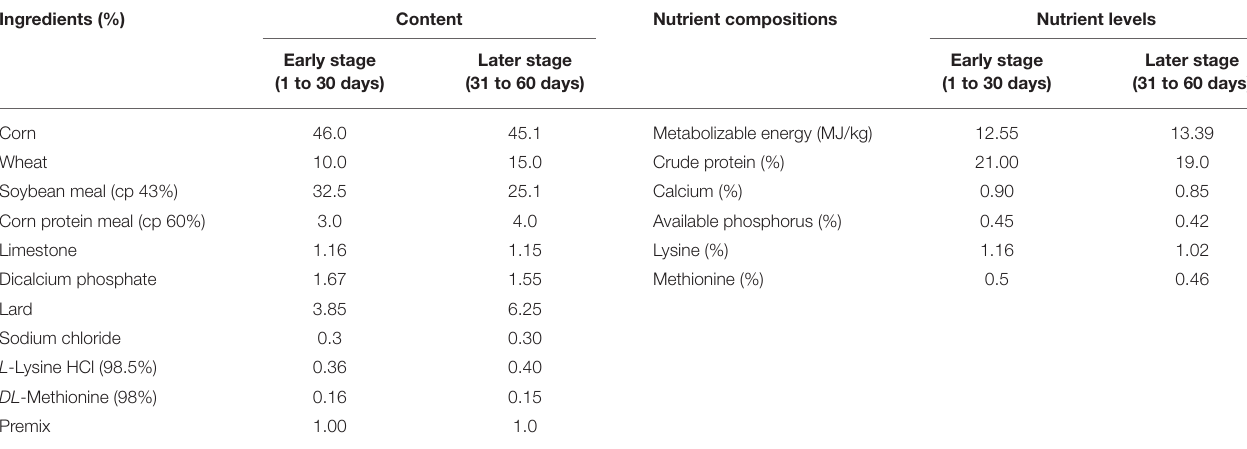
TABLE 1 | Composition and nutrient levels of basal diets (air-dry basis).